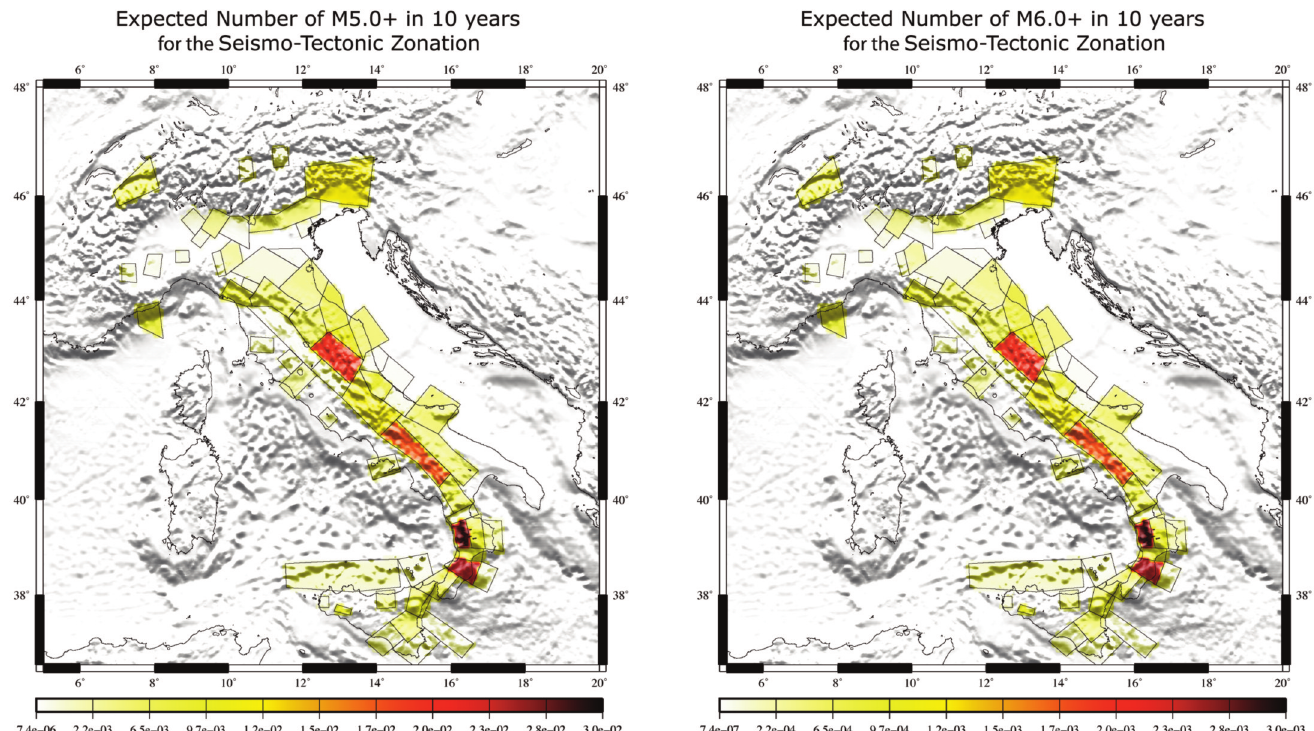
5.0+; right, M 6.0+. The l l